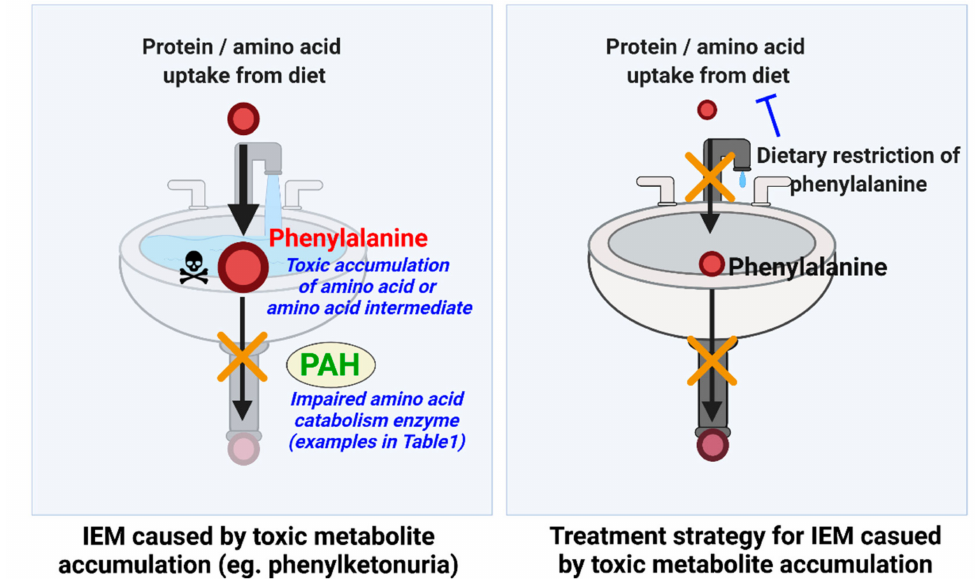
Figure 1. Kitchen sink model for IEM caused by toxic metabolite accumulation. As the majority of IEMs appear to be caused by the accumulation of the substrate of the enzyme that is impaired by the underlying mutation, the pathology and treatment can be conceptualized as a sink. Using phenylketonuria as an example, the loss of function mutation in phenylalanine hydroxylase leaves individuals unable to metabolite phenylalanine; thus, the drain of the sink is blocked and leads to an overflow of phenylalanine in the individual and accumulation of toxic phenylalanine byproducts. Importantly, dietary restriction of phenylalanine prevents the pathology, just as turning off the faucet prevents an overflow. This general sink mechanic appears to be in play in the majority of amino acid breakdown disorders, as described in this review. PAH: phenylalanine